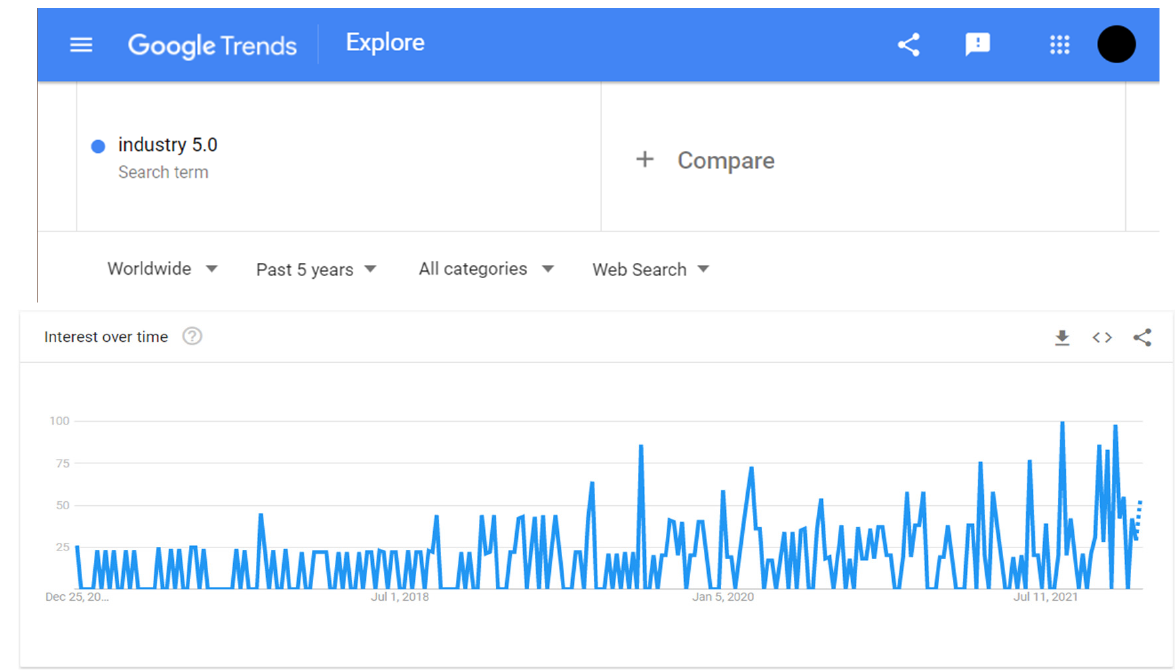
Figure 1. Research publications related to Industry 5.0 over the last 5